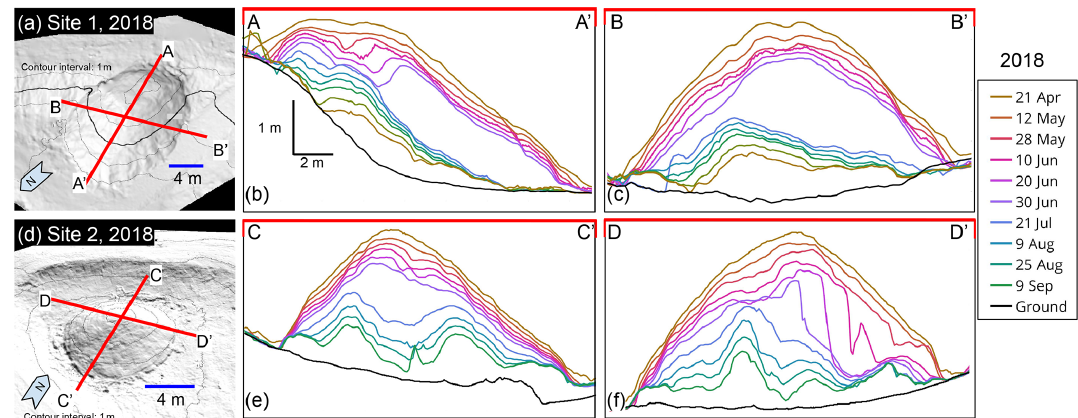
Figure 6. Snow pile topographic change over time in 2018. (a) Oblique view of digital surface model (1m contours) of 2018 snow pile at Site 1 with cross sections A – A (cid:48) and B – B (cid:48) (21 April 2018). (b) Profiles for each terrestrial-laser-scan survey (21 April to 9 September 2018; n = 13) along section A – A (cid:48) . (c) Profiles for each survey along section B – B (cid:48) . On 3 July 2018, 50m 3 of snow was removed from the pile at Site 1. (d) Oblique view of digital surface model (1m contours) of 2018 snow pile at Site 2 with cross sections C – C (cid:48) and D – D (cid:48) (21 April 2018). (e) Profiles for each terrestrial-laser-scan survey (21 April to 9 September 2018; n = 12) along section C – C (cid:48) . (f) Profiles for each survey along section D – D (cid:48) . Each scan represented by a line in panels (b) , (c) , (e) , and (f) as indicated in